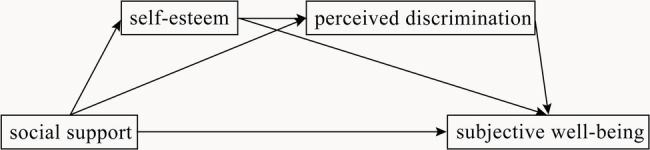
Hypothetical model.